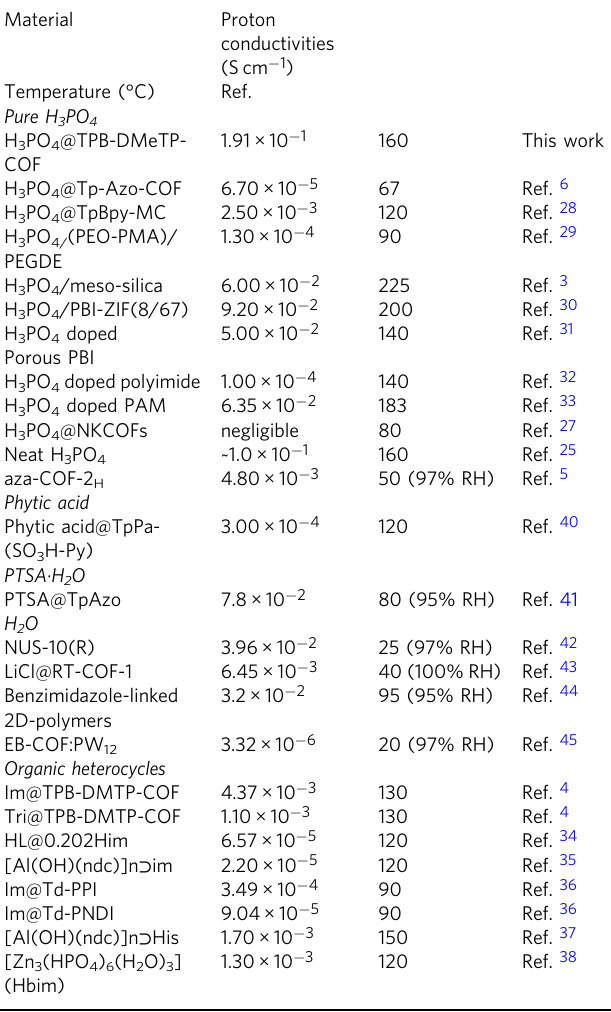
Table 1 Comparison of proton conductivities in some reported materials using phosphoric acid or organic heterocyclic derivatives as proton